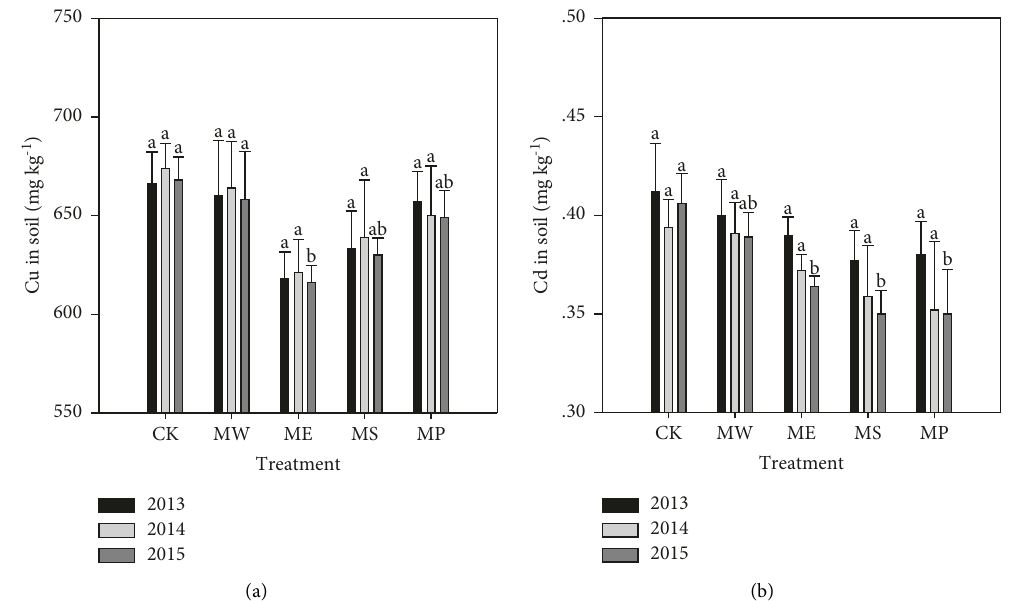
Figure 1: Total Cu and Cd concentrations in five soils during 3 years. MW � Setaria lutescens, ME � Elsholtzia splendens, MS � Sedum plumbizincicola, and MP � Pennisetum sp. Different lowercase letters indicate significant differences in the same treatment during the three years ( n � 3, P < 0 .